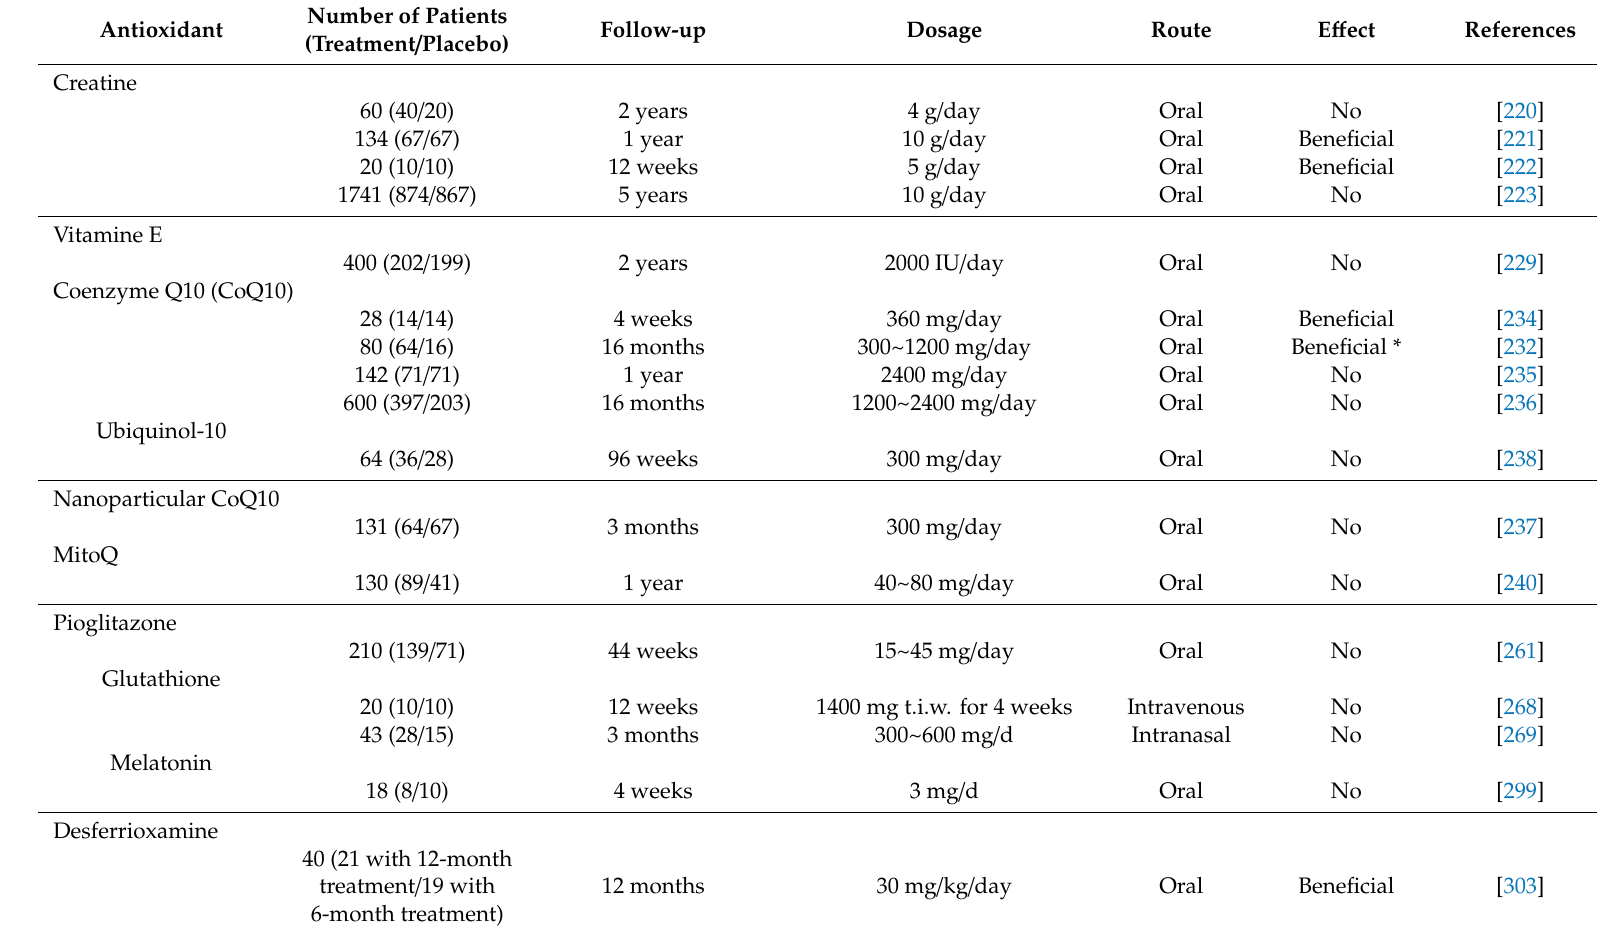
Table 2. Clinical trials of antioxidants in treating Parkinson’s